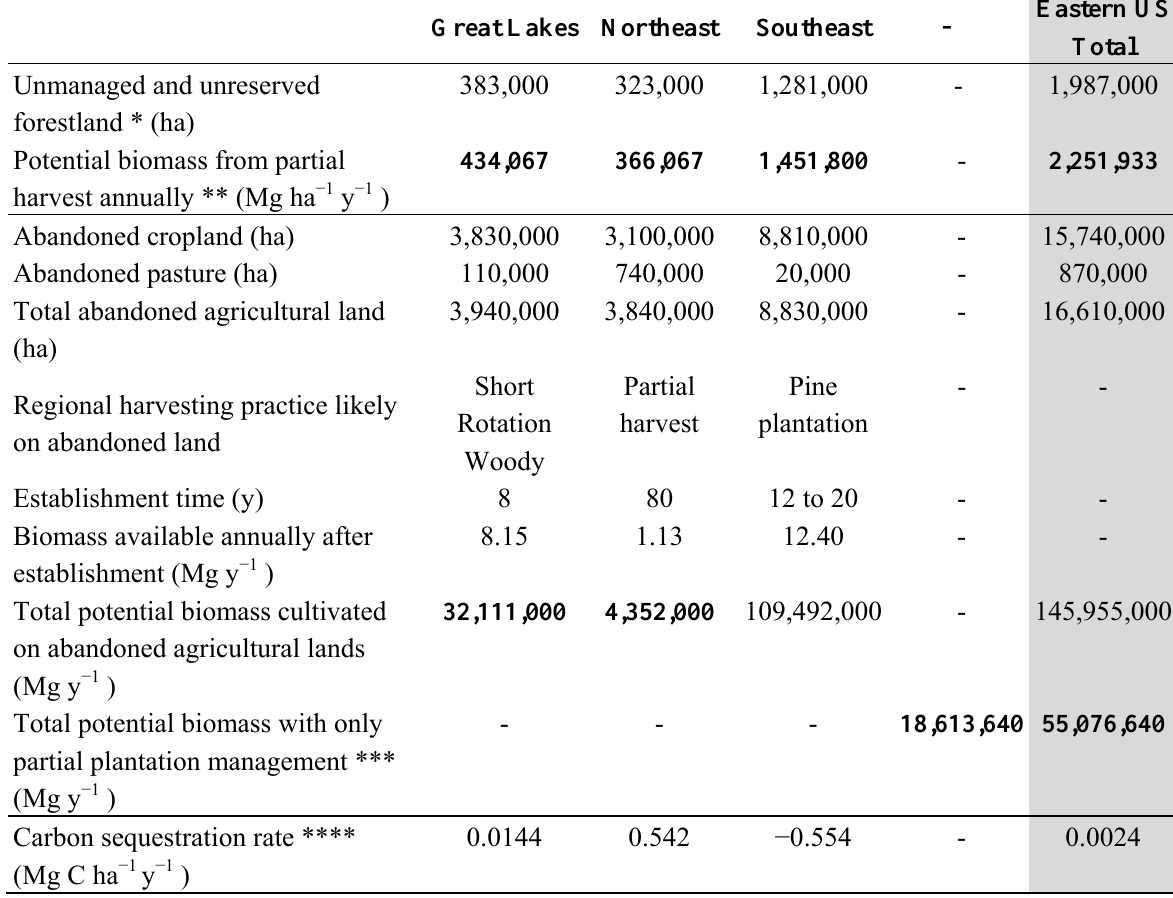
Table 2. Estimates of land and potential production of woody biomass for